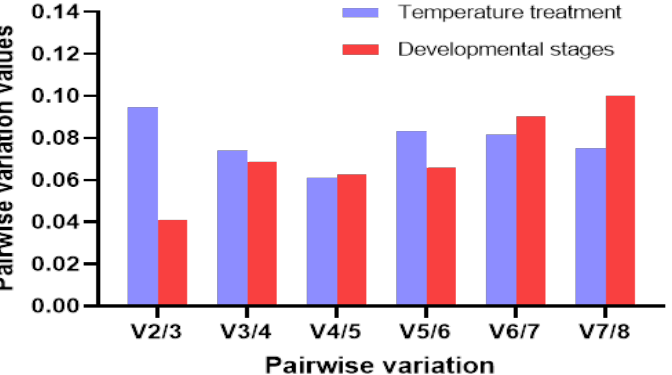
Figure 5. Pairwise variations (V) of the expression stability of the candidate reference genes calculated by geNorm in two experimental sets. Pairwise variations (Vn/n + 1) were analyzed to determine the optimal number of the reference genes for normalizing qRT-PCR data.